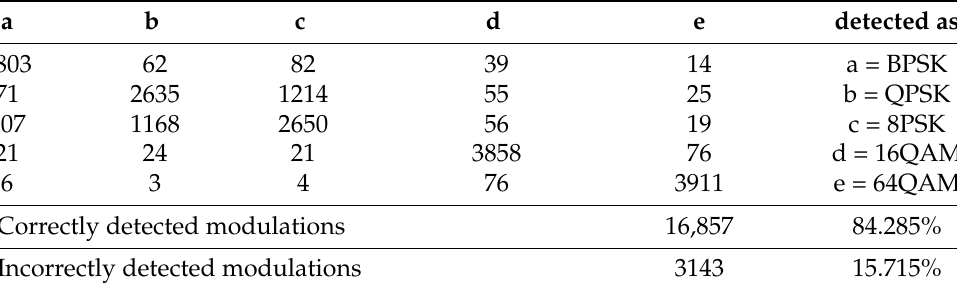
Table 6. Confusion matrix for Adaboost using J48 as a base MLT with L = 3, N A = 4, SNR SR =